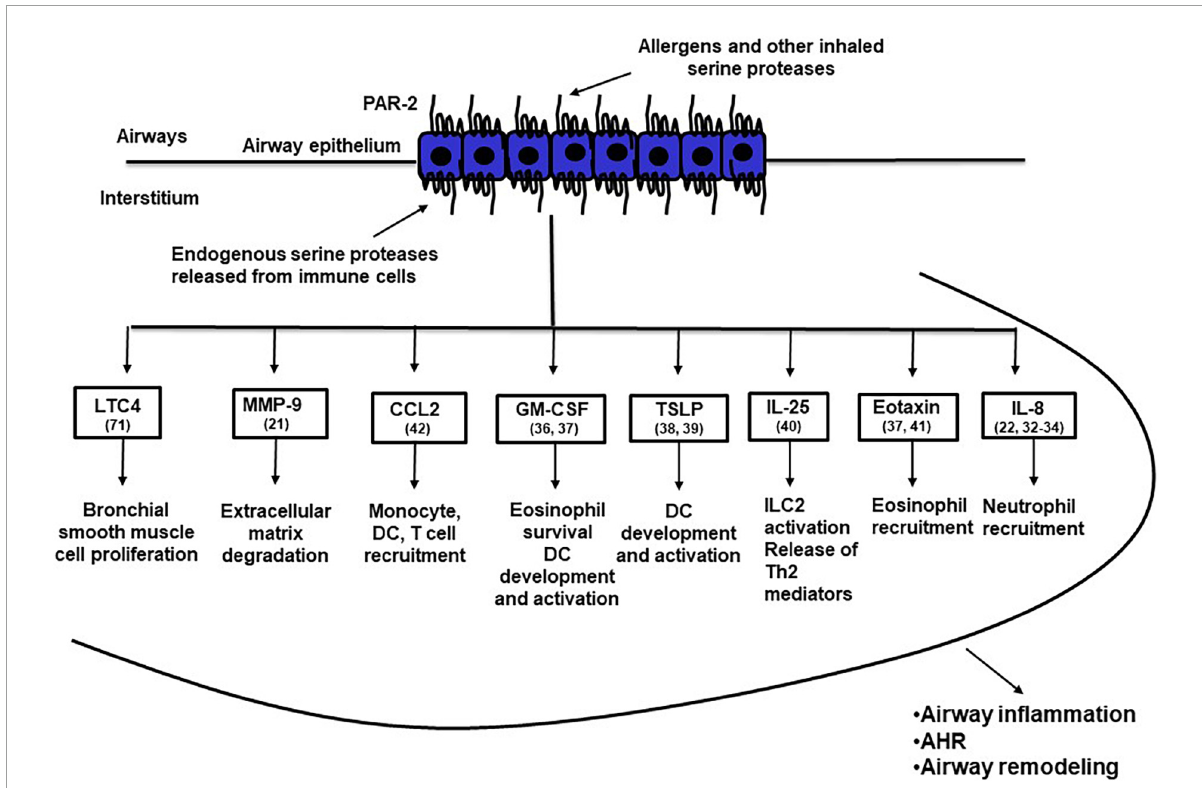
FIGURE1 PAR-2 activated airway epithelial cells release a variety of inflammatory mediators that may induce airway inflammation, airway hyperresponsiveness and airway remodeling. The numbers in brackets after the name of specific inflammatory mediators indicate the reference of the main text where that mediator is discussed. AHR, airway hyperresponsiveness; CCL2, CC motif chemokine ligand 2; DC, dendritic cell; GM-CSF, granulocyte-macrophage colony-stimulating factor; ILC2, type 2 innate lymphoid cells; IL-25, interleukin 25; IL-8, interleukin 8; LTC4, leukotriene C4; MMP-9, matrix metalloproteinase 9; TSLP, thymic stromal